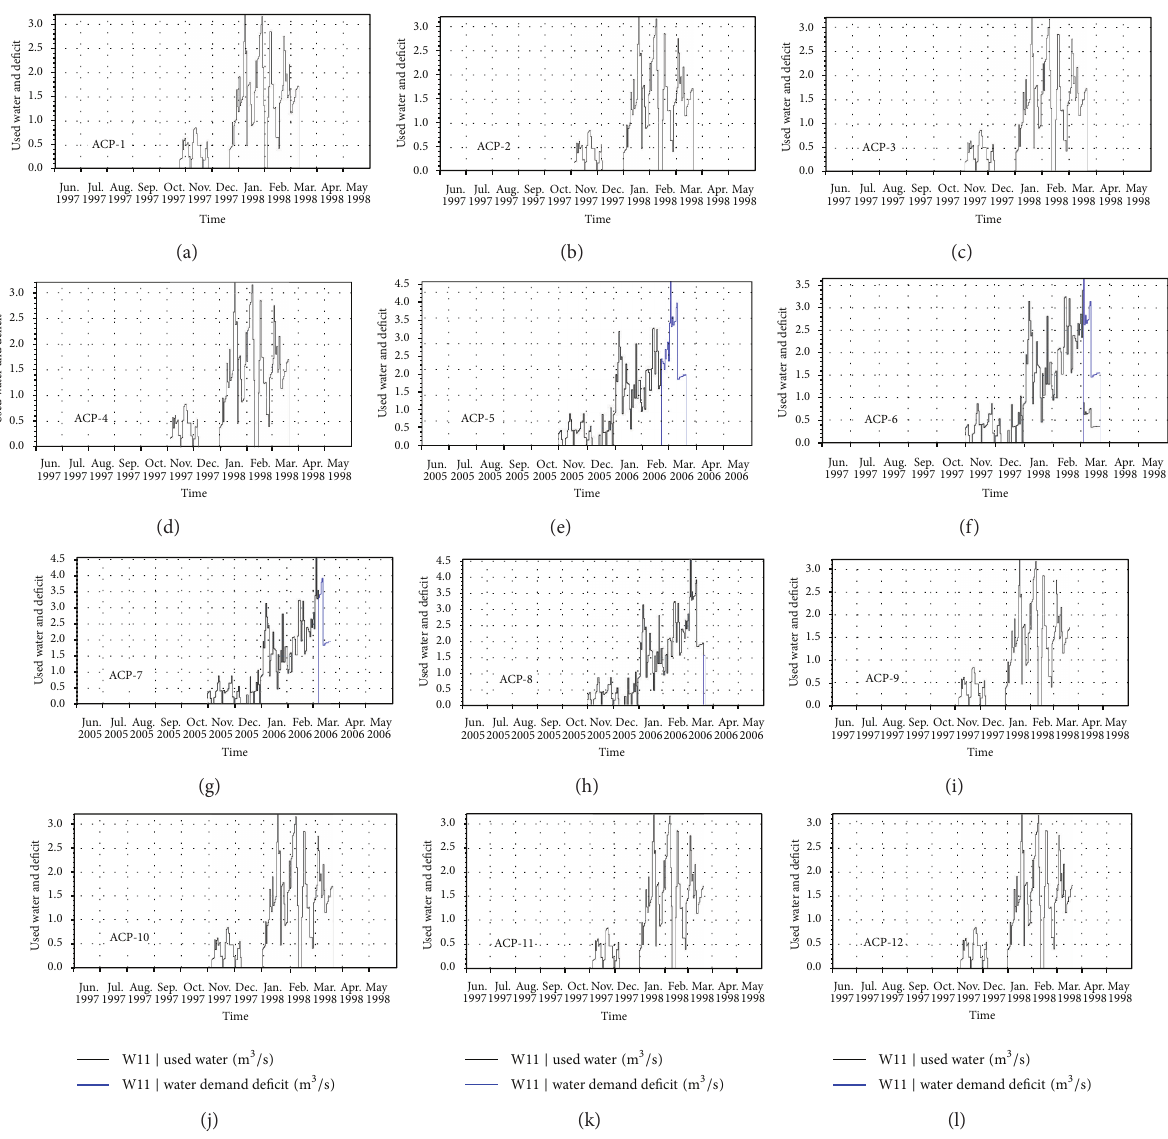
Figure 4: Demand deficit and used water for different scenarios (ACP-1 to ACP-12) in Madhya Pradesh part of the Ranagawan command.